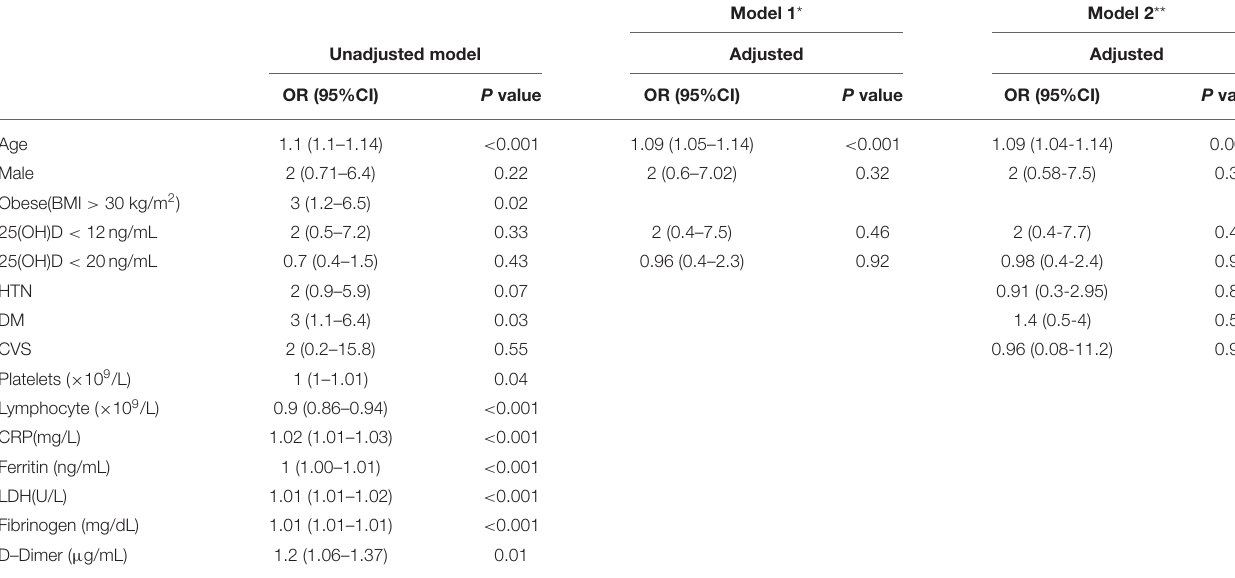
TABLE 3 | Predictors for COVID-19 severity using univariate and multivariate logistic regression